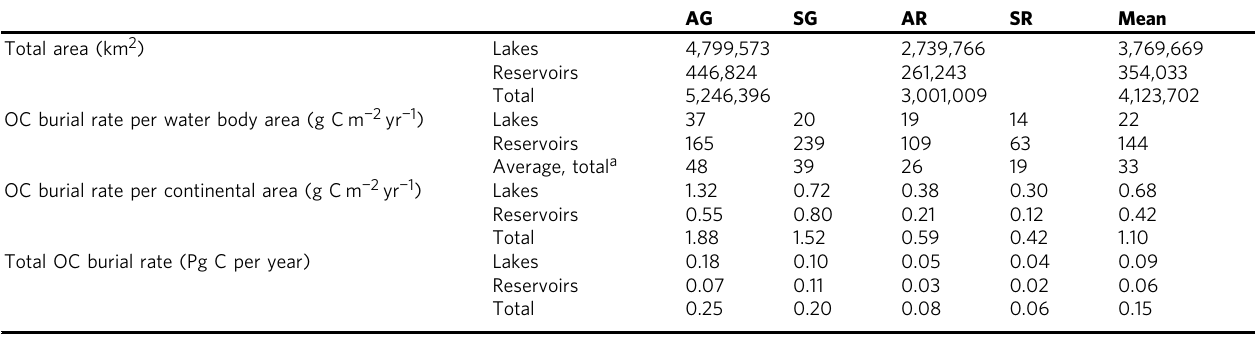
Table 1 Summary of global estimates derived from the four scenarios and their mean